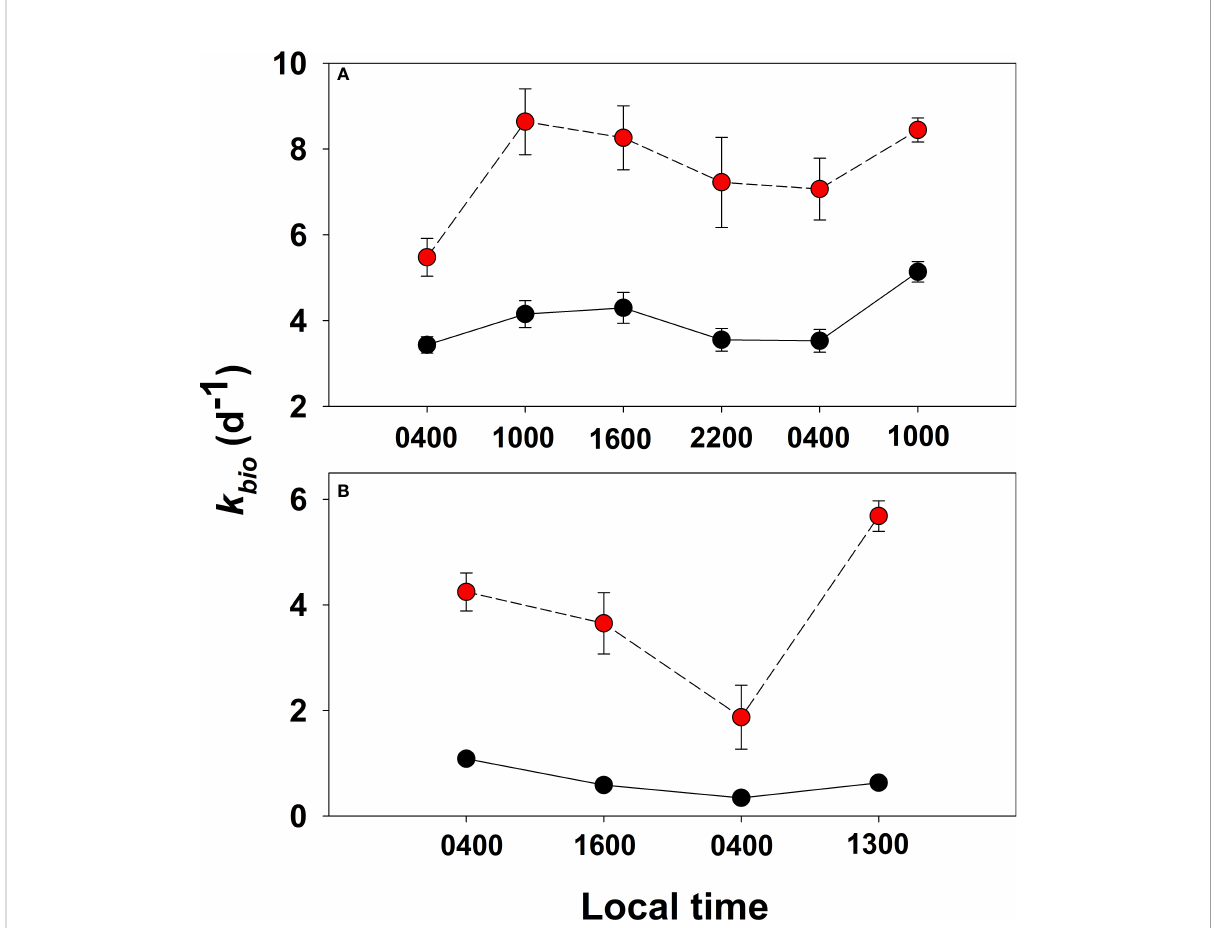
FIGURE 10 First-order rate constant ( k bio ) for the biological consumption of acrylate d (black circles) and DMSP d (red circles) determined from dark incubations of un fi ltered seawater collected from the coral reef BR station (panel A ) and open ocean OO station (panel B ) during the diel study. Error bars depict the standard deviation from triplicate incubations; errors smaller than the symbol are not